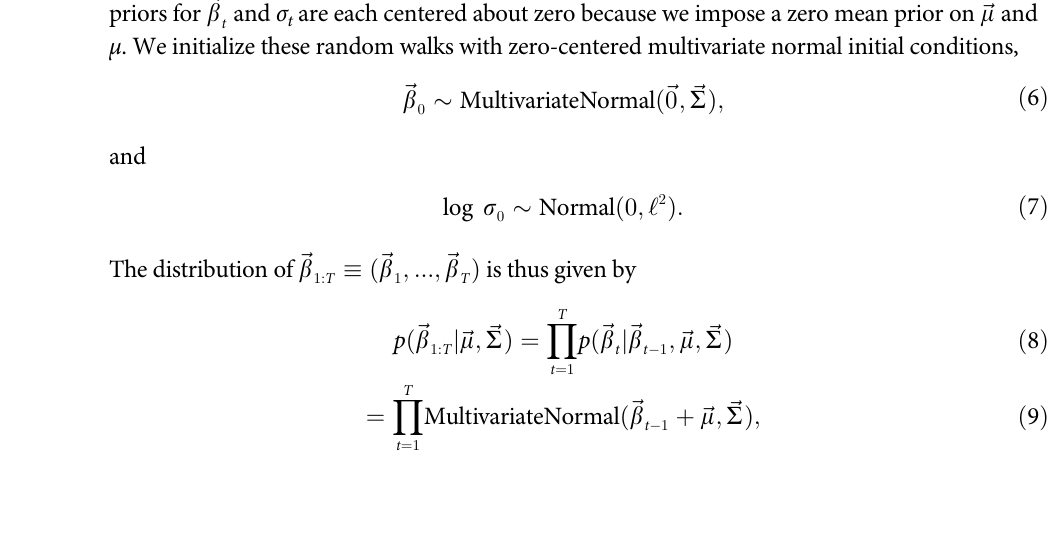
Fig 1. A graphical model representing the likelihood function given in Eq 5. Latent log σ t and β t evolve as biased random walks, while y tn and ~ X observable random variables and exogenous parameters respectively. The entire temporal model is plated across districts N = 18.